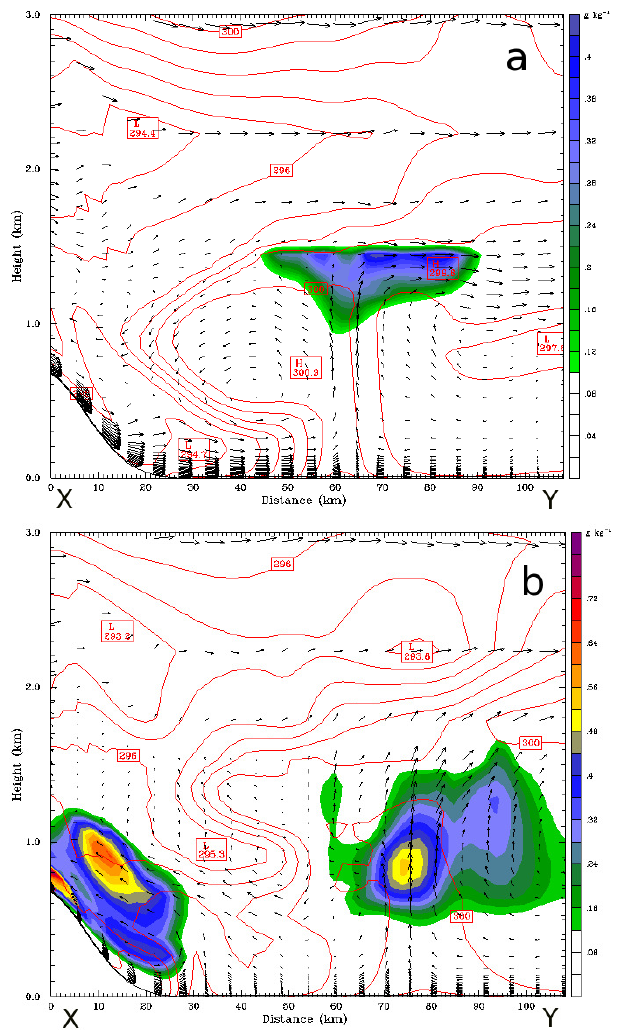
Figure 4. Vertical cross sections along the yellow line of Fig. 1 of the wind (arrows), equivalent potential temperature (red contour lines) and cloud mixing ratio (colored contour) at 00:00 (a) and 03:00UTC (b) on 14 December 2010. The maximum wind speed is 9.5 m s − 1 approximately.